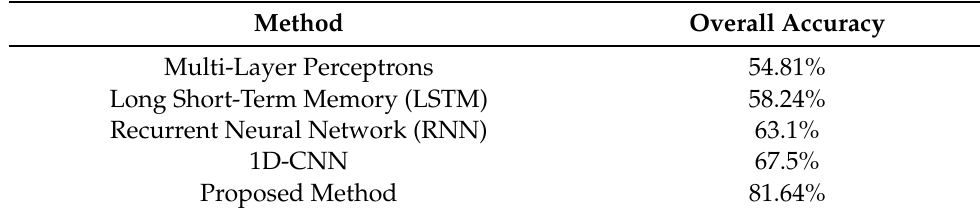
Table 1. Results